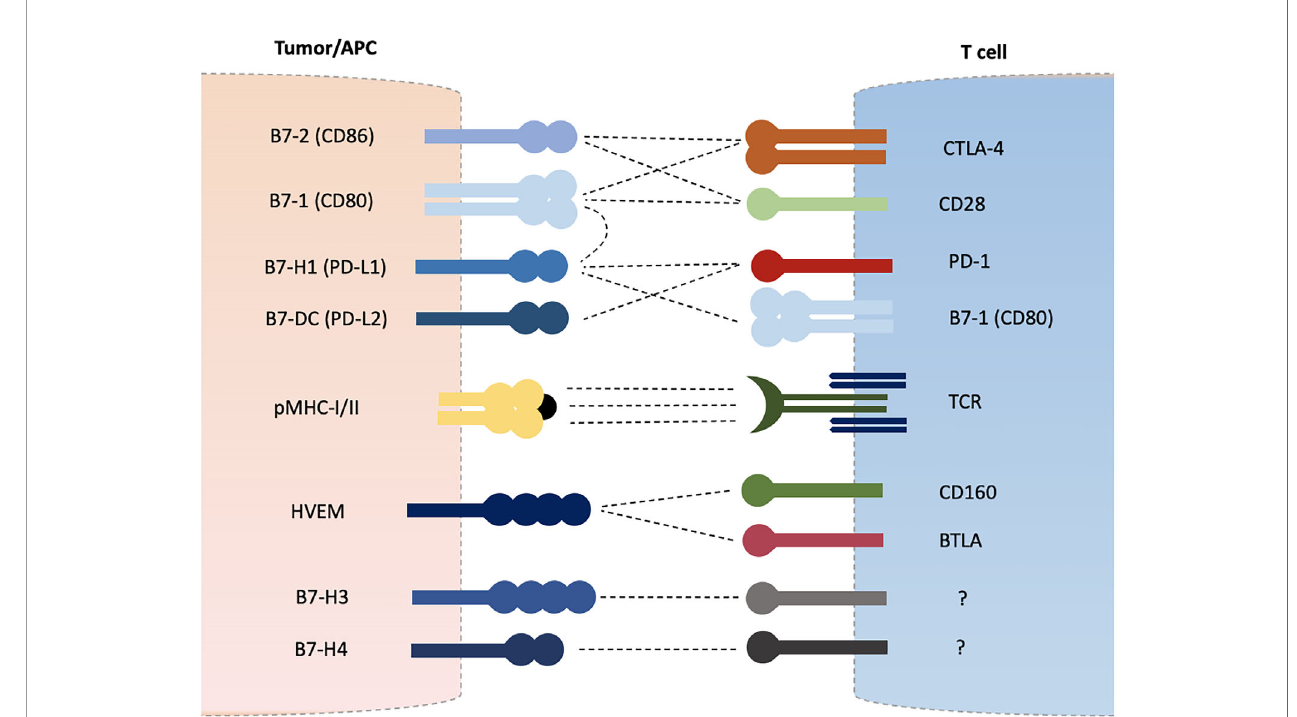
FIGURE 1 | B7-CD28 Family Coinhibitory Checkpoint